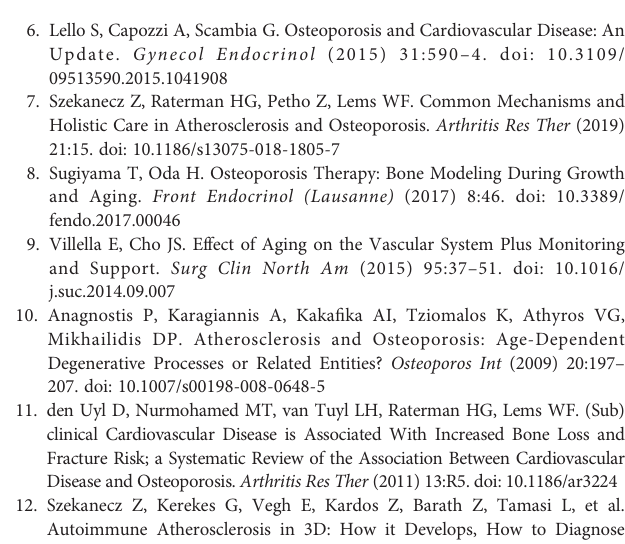
Supplementary Figure 2 | Volcanic map of DEGs (|logFC| > 1 and adj. p-value < 0.05) in GSE35958 (A) and in GSE100927 (B) . Supplementary Figure 3 | The functional enrichment analysis of eight common miRNAs through HMDD